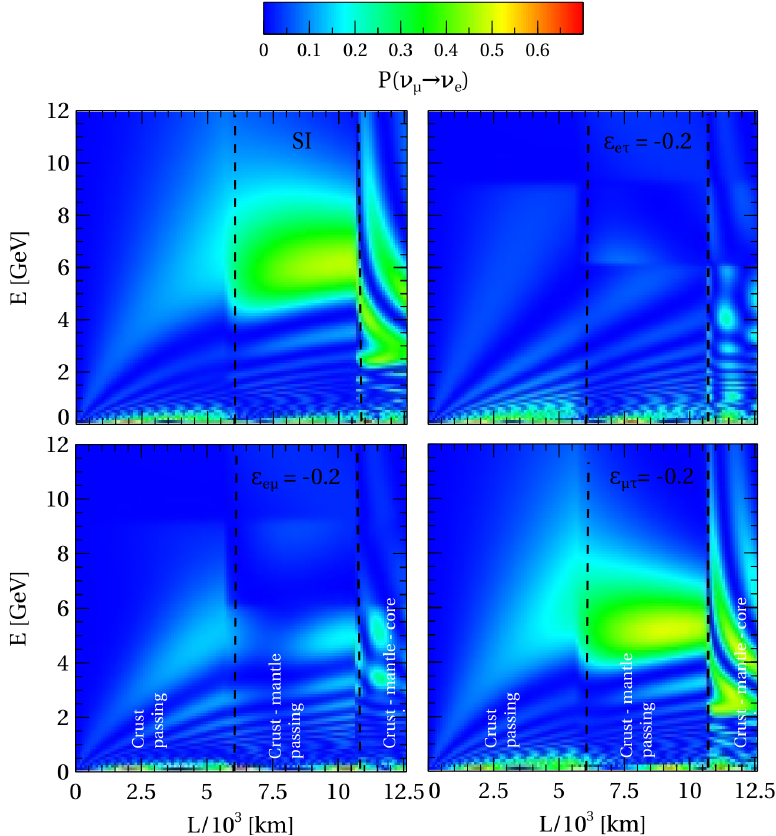
Figure 10 . Oscillogram of ν µ → ν e transition probability as a function of baseline L and energy E . Top left panel corresponds to SI case and other three panels correspond to the cases in presence of non-zero negative NSI parameters (taken one-at-a-time with a strength of 0.2 as shown in the legends). The values of the oscillation parameters used in this plot are taken from table 2 with θ 23 = 45 ◦ and